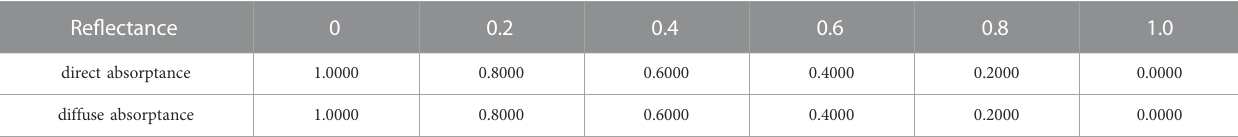
TABLE 7 Summary of direct absorptance and direct transmittance, for different re fl ectance of slat surface. Re fl